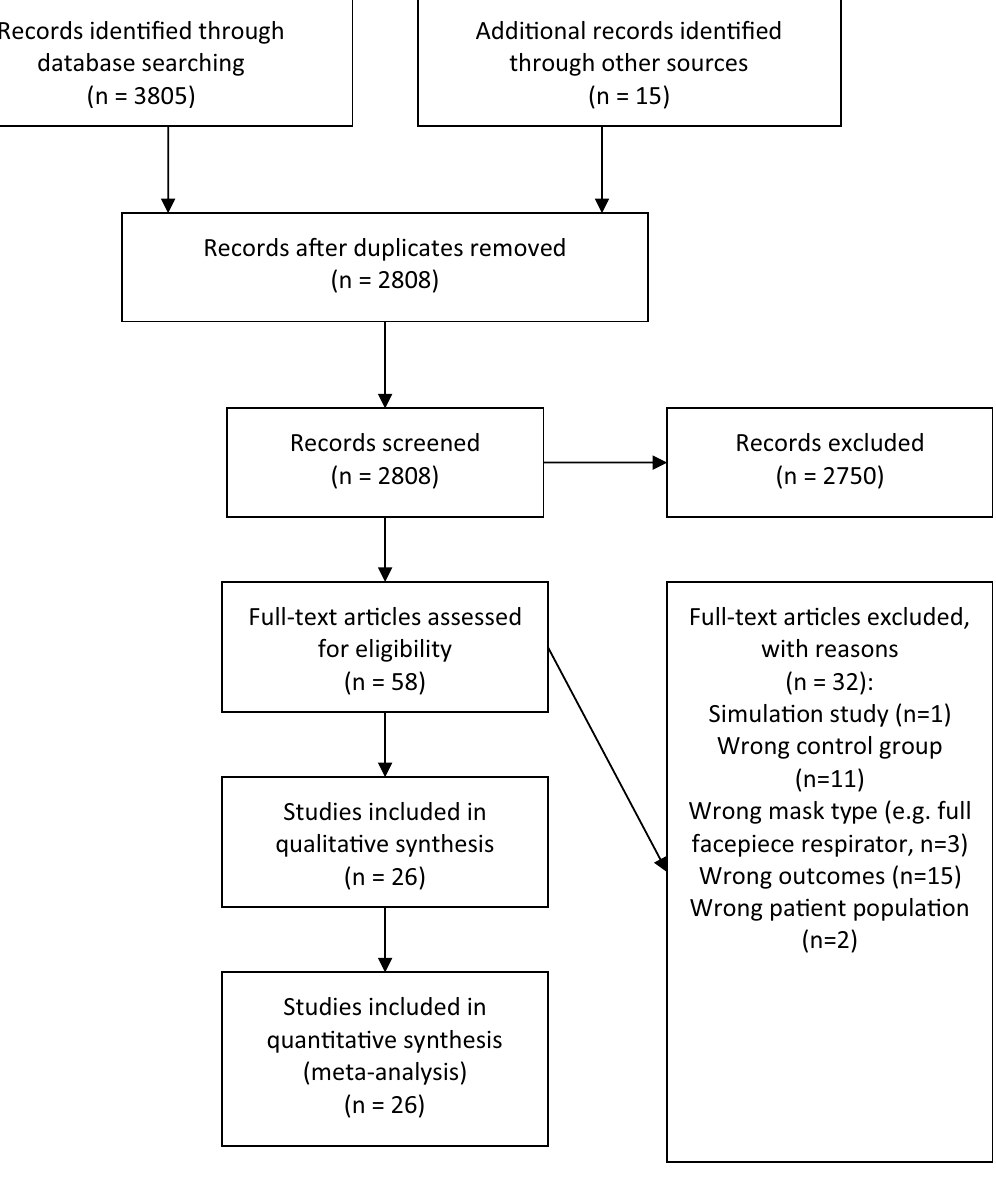
Figure 1. Flow diagram of the study selection